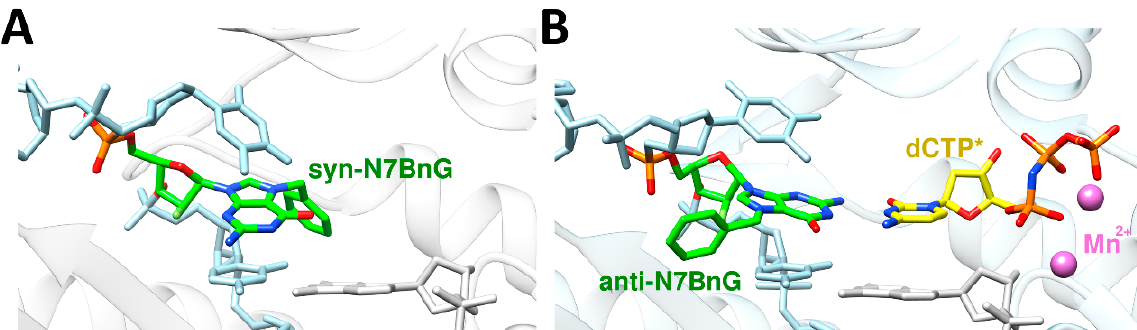
Figure 6. The bypass of N7BnG by pol η and the role of syn–anti equilibrium and catalytic metals in the bypass. ( A ) In the presence of Mg 2+ , N7BnG displayed syn conformation, and this conformation hindered the base pair with the incoming dCTP* (PDB ID: 7L69). ( B ) In the presence of Mn 2+ , N7BnG showed anti conformation, and this conformation enabled the base pair with the incoming dCTP* (PDB ID: 6W5X).